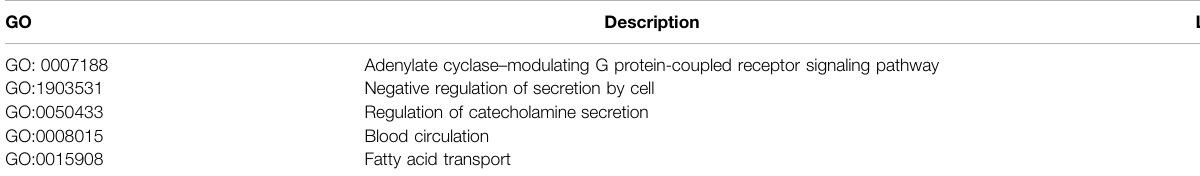
TABLE 3 | Main biological processes of the top 2 MCODE gene functions.